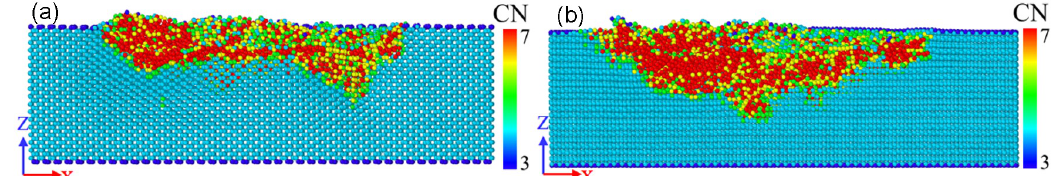
Figure 10. Cross-sectional view of deformation behaviors of ( a ) GaAs(110) and ( b ) GaAs(111) at a sliding distance of 10 nm. The scratching depth is 1.5 nm. The atoms are colored by CN.